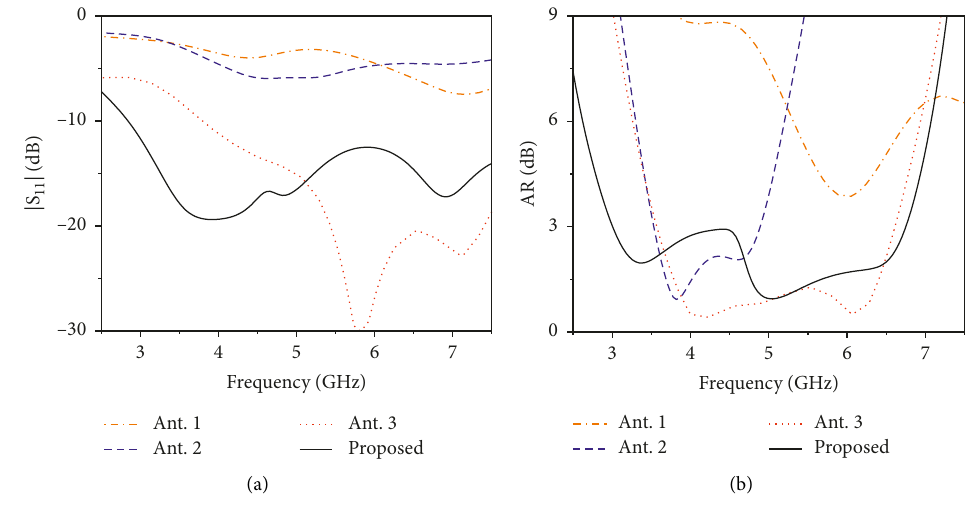
Figure 3: Results for four evolutional models. (a) | S